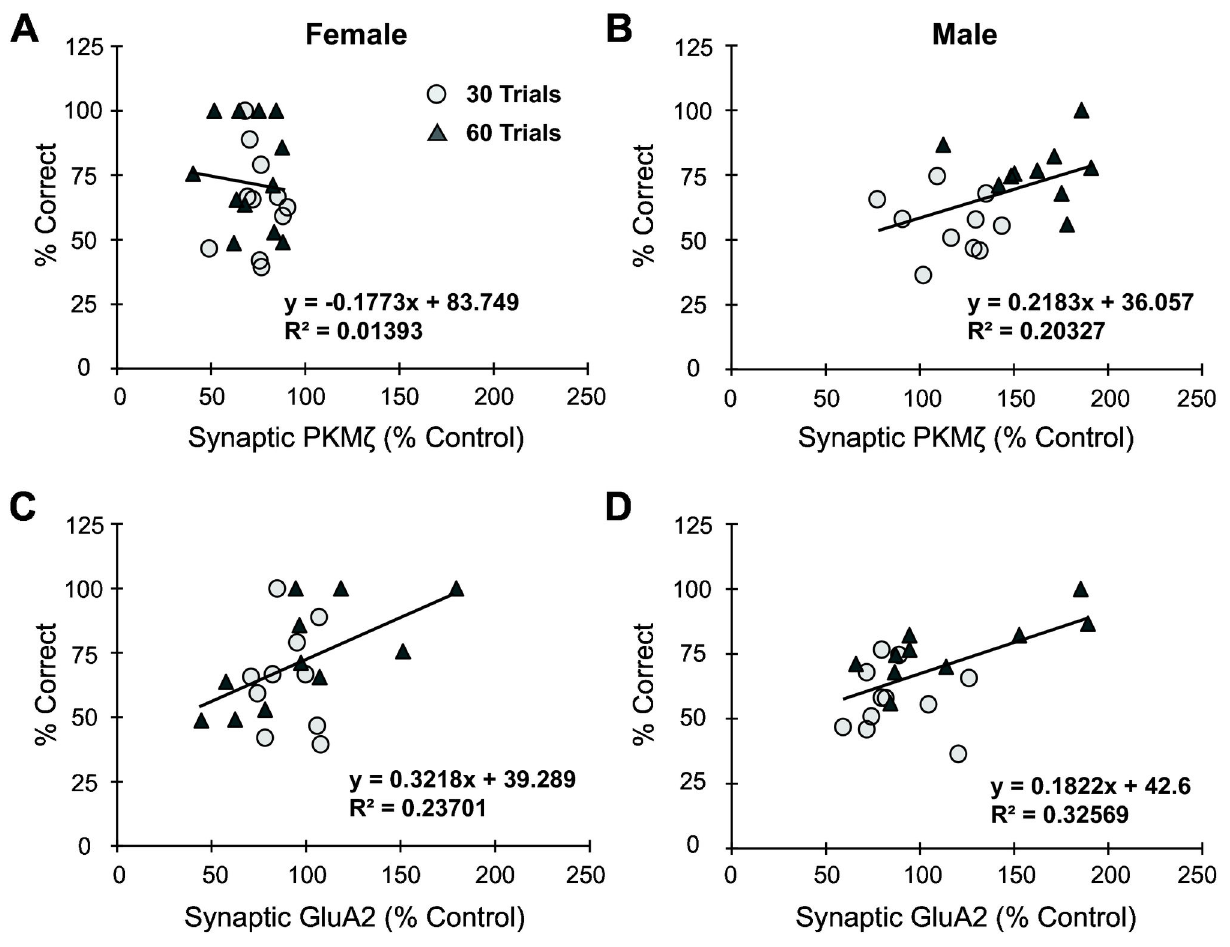
Figure 4. Synaptic PKMζ and GluA2 expression differentially correlates with memory retention between sexes. (A, B) Males, but not females, showed a significant correlation between retention test performance (percent correct scores) and synaptic PKMζ levels in the hippocampus. (C, D) Both males and females showed a significant correlation between retention tests scores and synaptic GluA2 levels in the